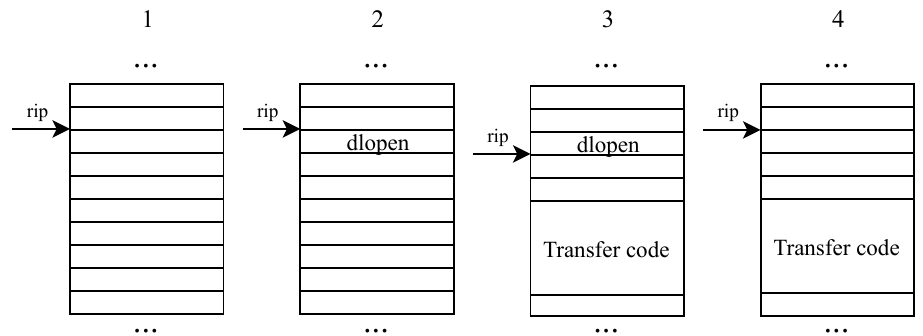
Figure 3. Target’s process during the transfer code injection: Stage 1 shows the initial state of the target’s process. At Stage 2, the manager alters the process so that the next instruction is a call to dlopen . Stage 3 shows the process after dlopen is executed. At Stage 4, the manager removes the dlopen call and returns the instruction pointer to its original value.